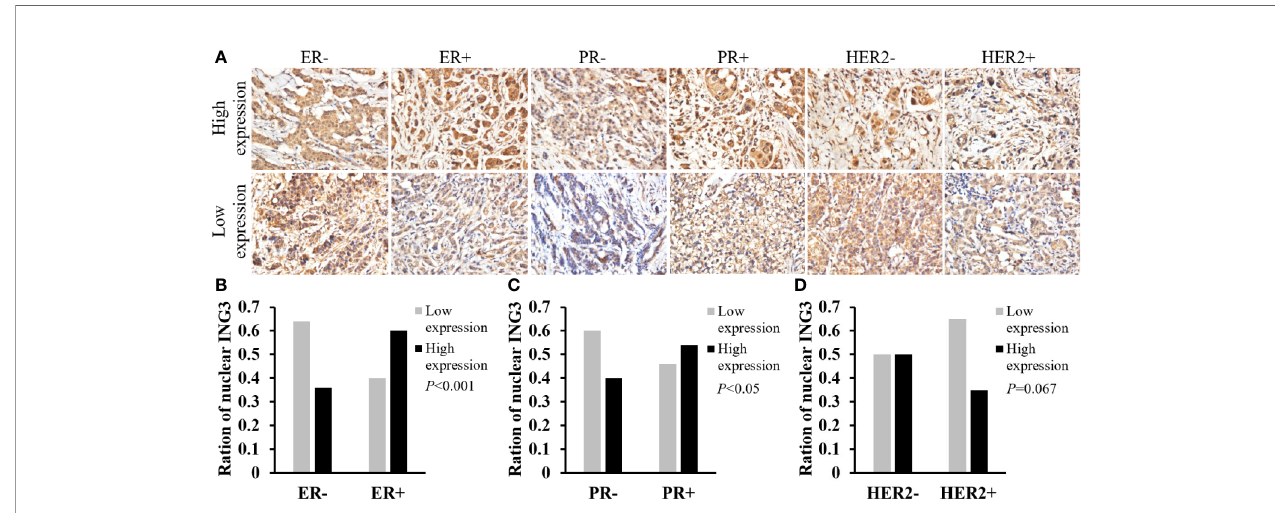
FIGURE 3 | Analyses of nuclear ING3 expression in breast cancer with status of ER, PR and HER2. (A) The representative images of nuclear ING3 staining in different status of ER, PR and HER2. (A) Magni fi cation, ×400. (B – D) The c 2 test and Spearman ’ s rank result of nuclear ING3 staining in breast cancer with in different status of ER, PR and HER2.